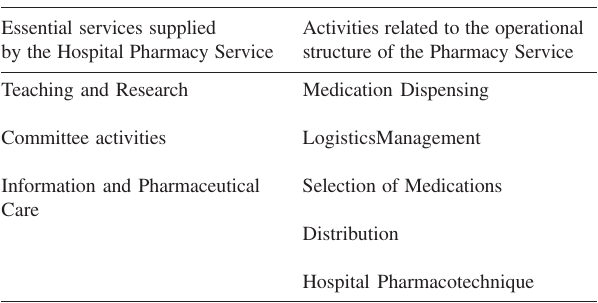
Table 2 - Components of the Hospital